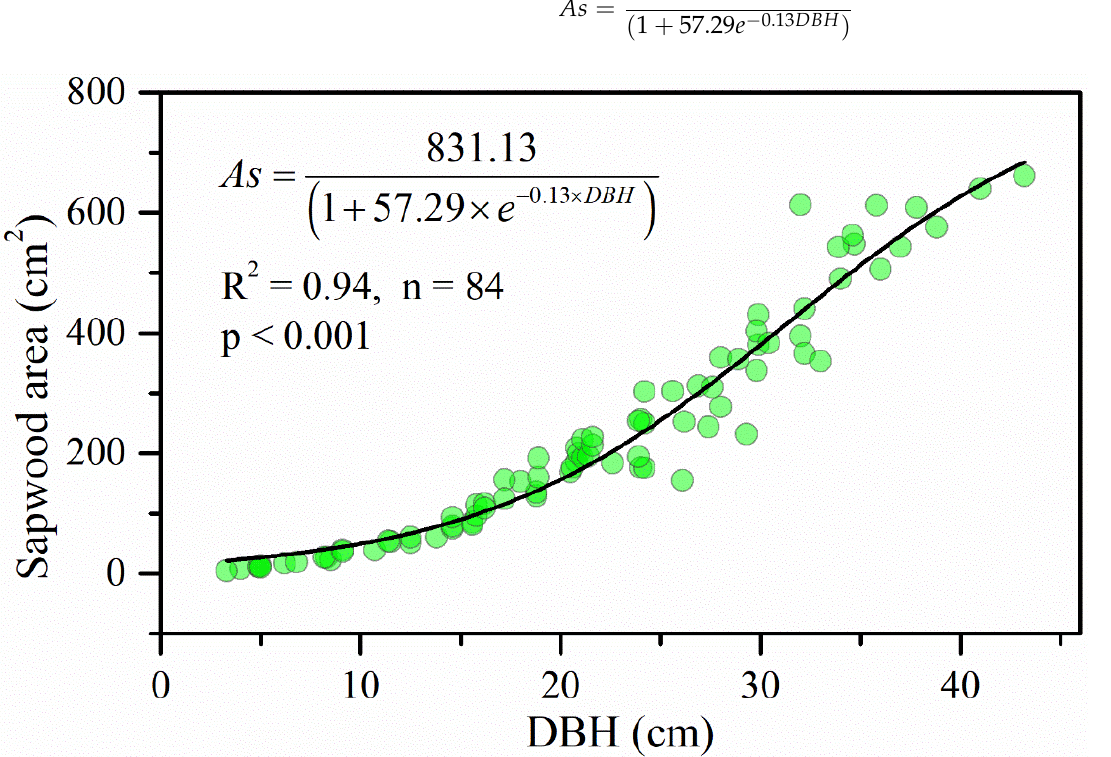
Figure 3. Relationship and fitting function between the diameter at breast height ( DBH ) and sapwood area ( As ) for Qinghai spruce ( P. crassifolia ).